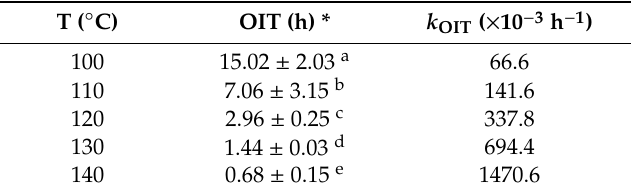
Table 1. Oxidation induction time (OIT) values and reaction rate constants ( k OIT = 1 / OIT) at five di ff erent temperatures T for avocado